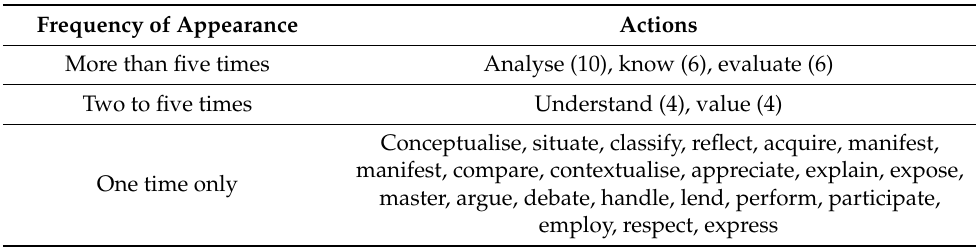
Table 6. Main actions contemplated in the objectives of the subject of Geography and History, according to the Orden de 14 de julio de